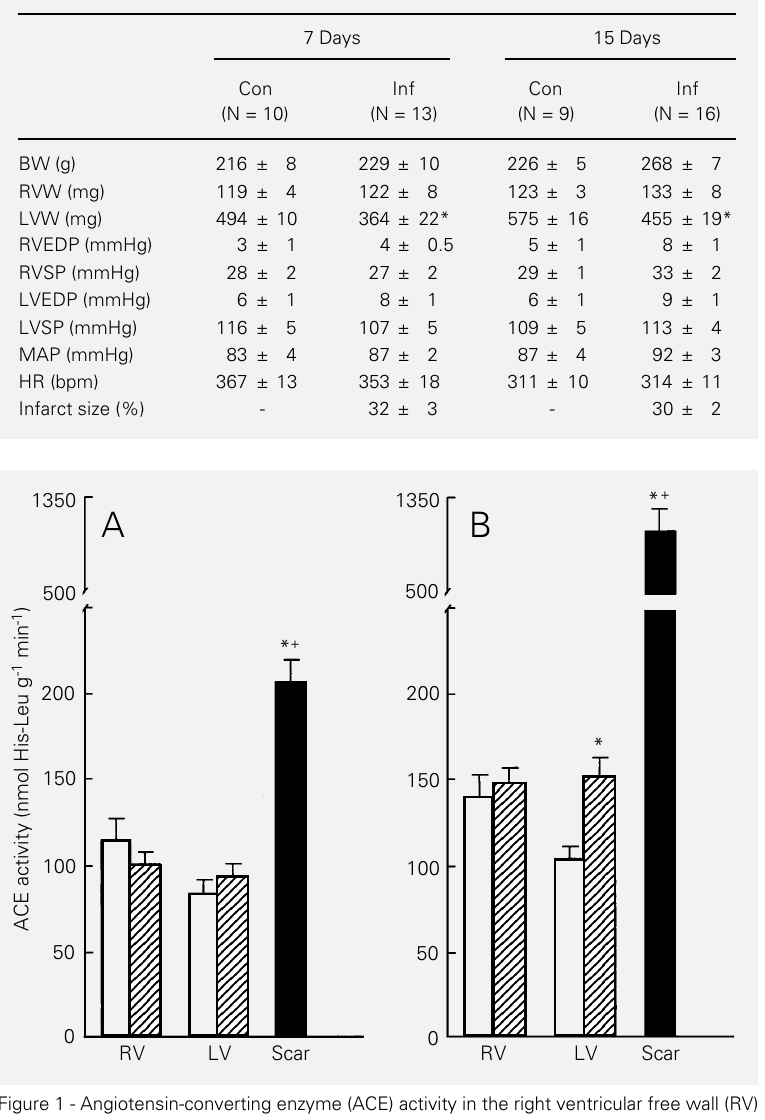
Table 1 - Weights of the ventricular chambers and hemodynamic data recorded in sham-operated control (Con) and infarcted (Inf) groups of rats. BW, Body weight; RVW, right ventricle weight; LVW, left ventricle weight; RVEDP, right ventricle end-diastolic pressure; RVSP, right ventricle systolic pressure; LVEDP, left ventricle end-diastolic pressure; LVSP, left ventricle systolic pressure; MAP, mean arterial pressure; HR, heart rate; N, number of rats. In the Inf group, the LV weight corresponds only to the weight of the surviving LV muscle. The infarct size is ex- pressed as the percentual area of the left ventricular surface covered by the scar